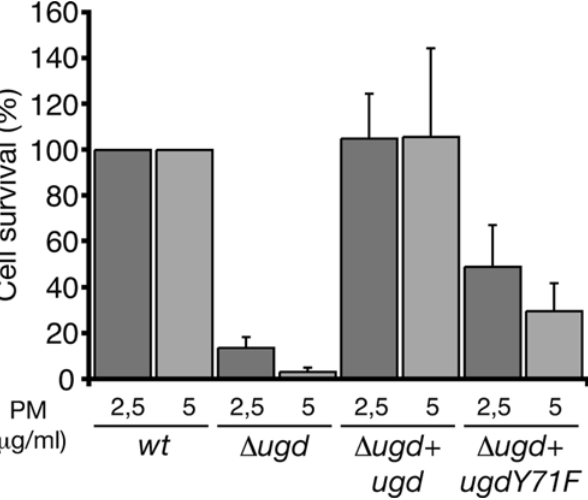
Figure 4. Influence of Ugd Tyr71 phosphorylation on poly- myxin resistance. Polymyxin resistance of E. coli mutants are expressed relatively to the survival of wild type taken as 100%. Resistance was measured in the presence of a polymyxin concentration of either 2.5 or 5 m g/ml. Standard deviations from six independent experiments are indicated with error